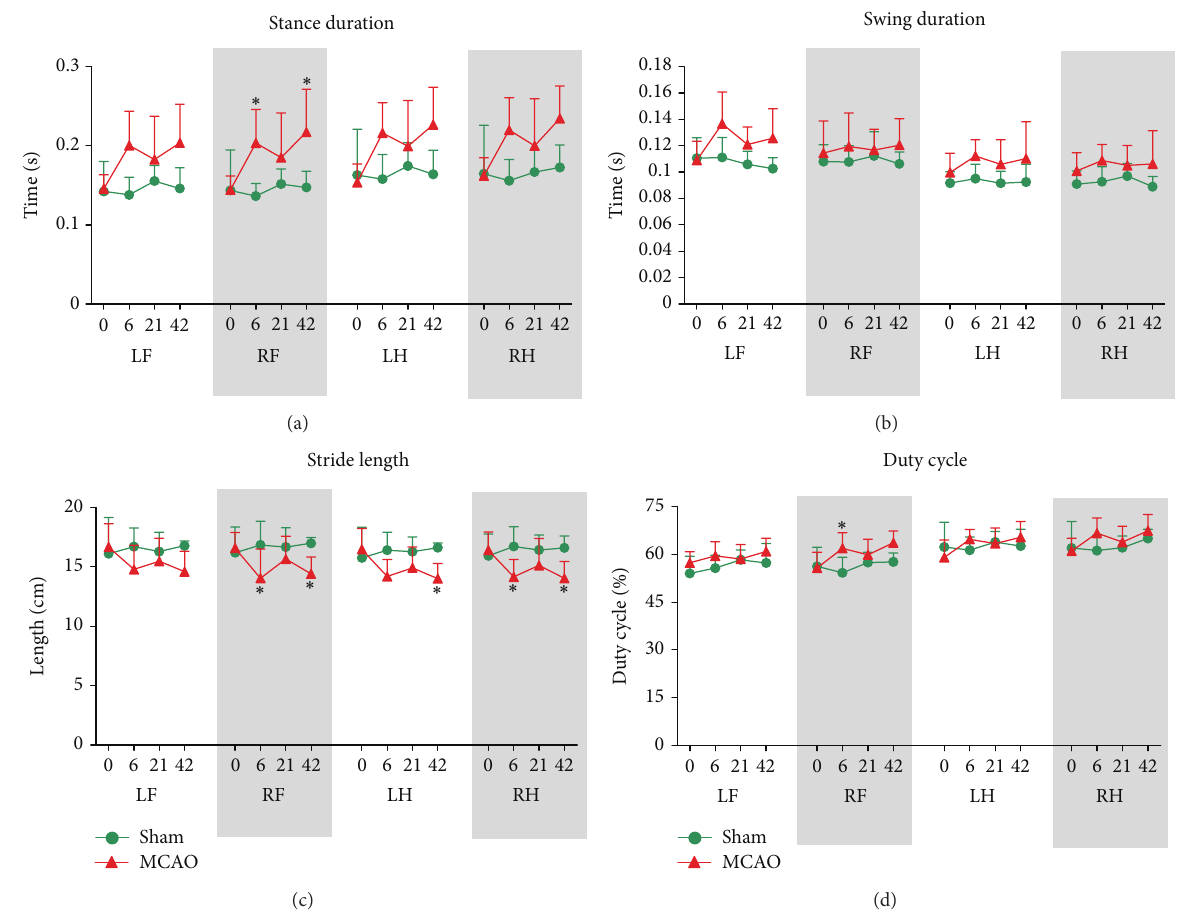
Figure 4: Effect of focal cerebral ischemia on temporal and comparative paw parameters. (a) Cerebral ischemia increased the duration of the stance phase of all paws at postoperative days 6 and 42. (b) Swing duration was only significantly different in the left forelimb (LF) at the acute phase after ischemia. (c) Stride length of MCAO animals was generally shorter. (d) Only the right forelimb (RF) of MCAO animals denoted longer duty cycle at postoperative day 6. All values are given as mean ± SD. Statistics: ∗ 𝑃 < 0.05 versus sham-operated